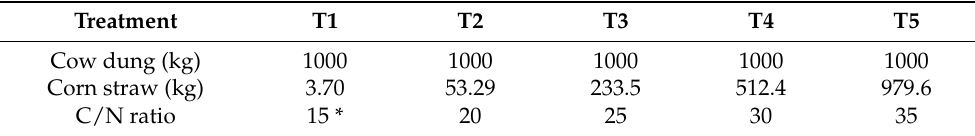
Table 2. Treatment